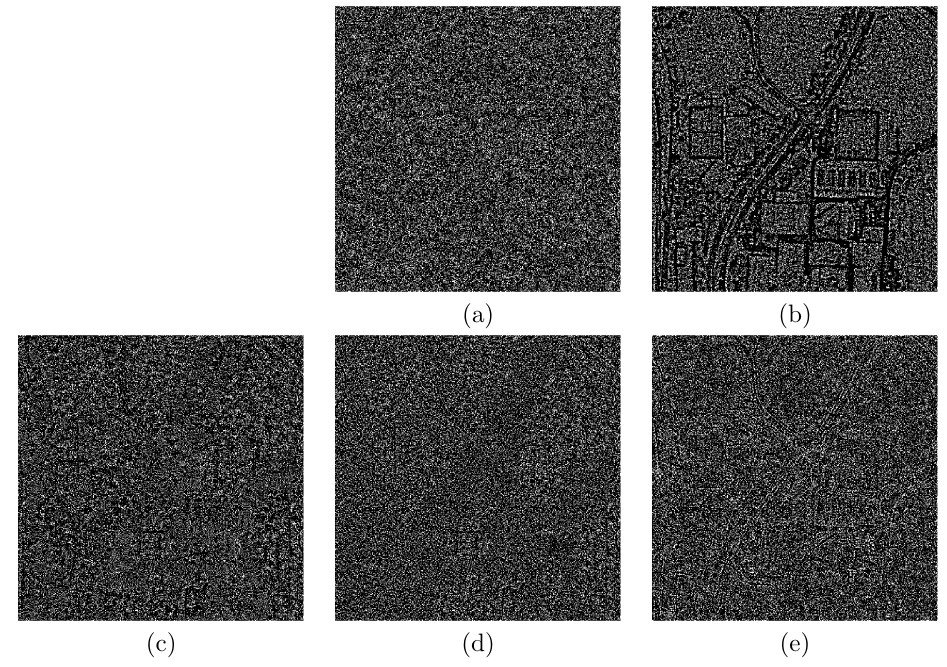
Figure 8. Rome test case: ratio images related to: ( a ) clean reference, ( b ) Kuan, ( c ) PPB-it, ( d ) FANS, and ( e )